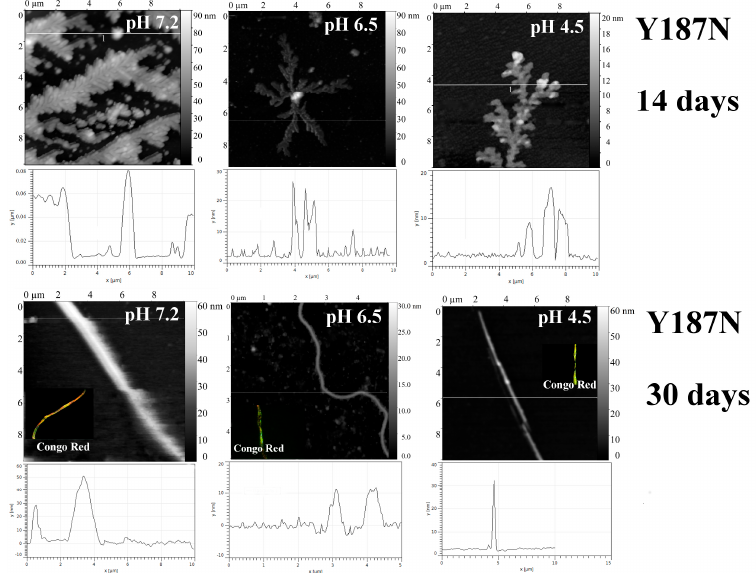
Figure 5. The morphology of Y187N aggregates at pH 7.2, 6.5 and 4.5 after 14 days and 30 days of incubation at 37 °C (AFM images obtained in tapping mode). Congo Red birefringence is shown.